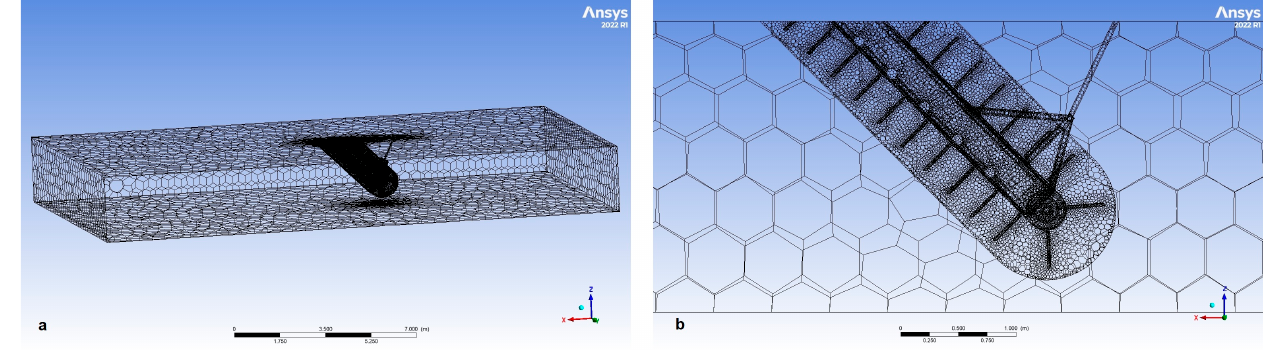
Figure 4. ( a ) Complete mesh including domain; ( b ) Refined mesh along the model. For all Computational Fluid Dynamics (CFD) simulations the turbulence model k- ω (SST) [28] with default y+ insensitive wall functions based on Launder and Spalding [29] was used where the boundary layers are not resolved by the grid and y+ is approximately 100. The CFD investigation was carried out using a SIMPLE (Semi-Implicit Method for Pressure-Linked Equations) pressure–velocity coupled solver with a first-order upwind scheme for all convection terms, i.e., equation of momentum, turbulent kinetic energy, and turbulent dissipation rate. For all residuals of momentum, continuity, and turbulence equations, the convergence conditions were set at 1 × 10 − 4 .